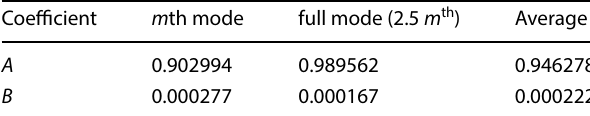
Table 6 α and β for different